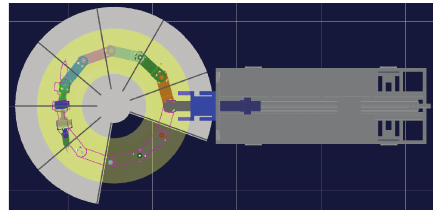
Figure 5: Schematic view of RHR integration on the Tokamak mockup (top view).